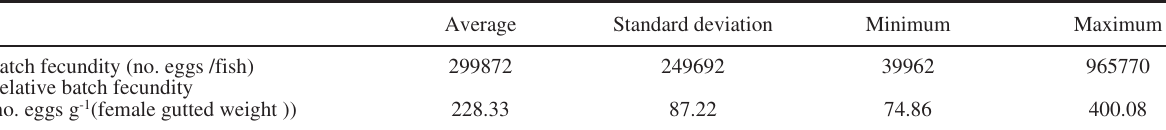
Table 4. – Batch fecundity values for M. merluccius.